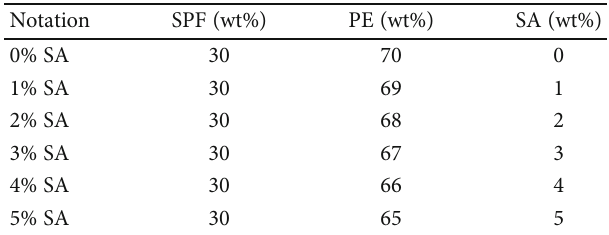
Figure 1: Fabrication process of SA-infused SPF/PE composite. Table 1: Notation of SPF/PE composite with various SA